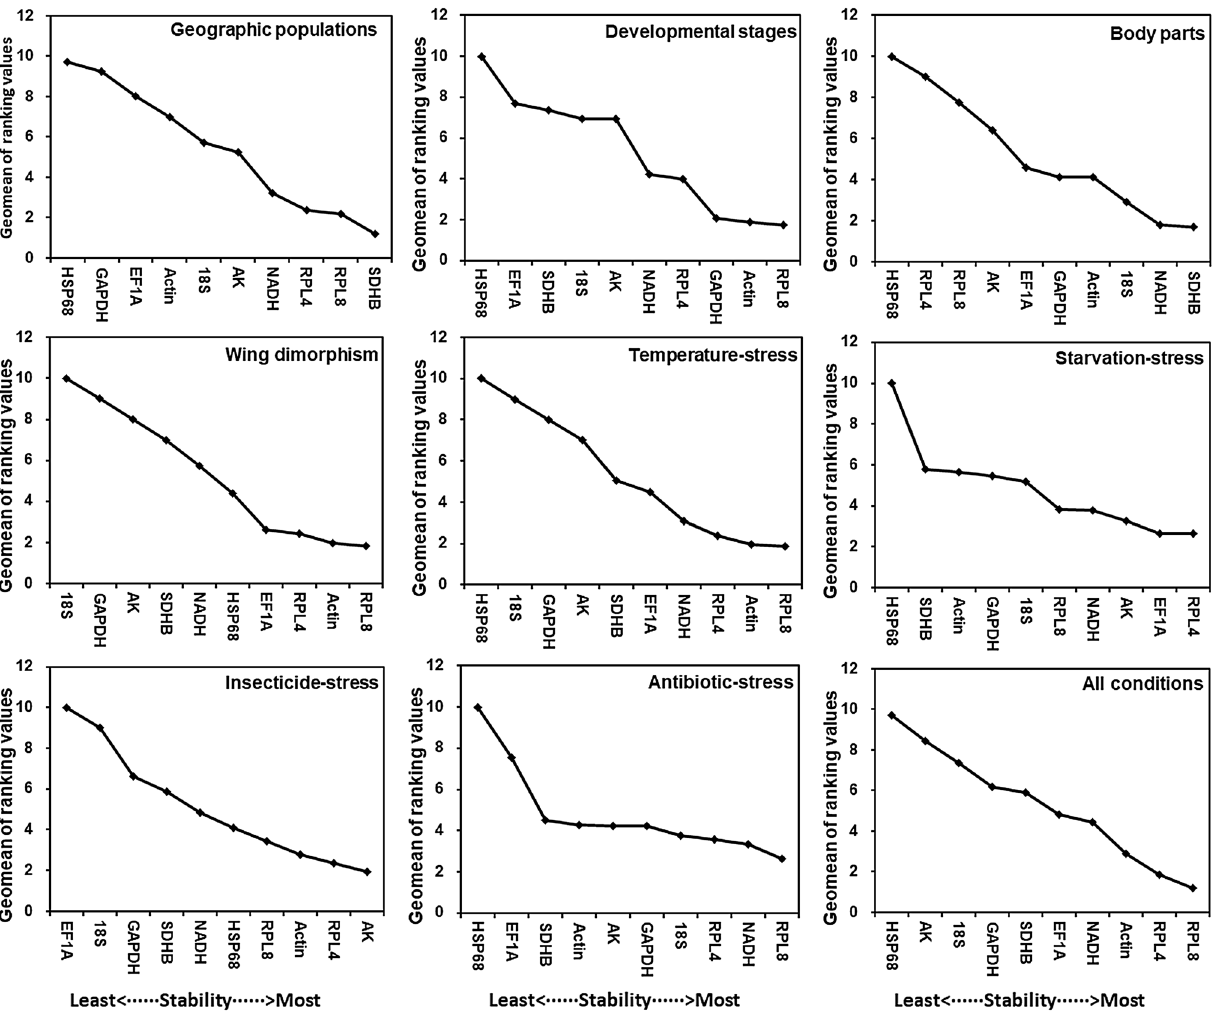
Figure 2. Stability of candidate reference gene expression levels in response to various treatments and conditions. In a RefFinder analysis, decreasing Geomean values correspond to increasing gene expression stability. The Geomean values for the following M. dirhodum samples are presented: adult samples from different geographic populations (Geographic population), samples for all developmental stages (Developmental stages), samples for different body parts of wingless adults (Body part), samples for winged and wingless adults (Wing dimorphism), adult samples exposed to different temperatures (Temperature-stress), fed and unfed adult samples (Starvation-stress), adult samples treated with different insecticides (Insecticide-stress), adult samples treated with antibiotic (Antibiotic-stress), and all samples for all treatments (All conditions). The candidate reference genes are as follows: Actin , Actin ; GAPDH , glyceraldehyde-3-phosphate dehydrogenase ; NADH , NADH dehydrogenase ; AK , arginine kinase ; SDHB , succinate dehydrogenase B ; RPL8 , ribosomal protein L18 ; RPL4 , ribosomal protein L4 ; HSP68 , heat shock protein 68 ; 18S , 18S ribosomal RNA ; and EF1A , elongation factor 1α were below the 0.15 cut-off value, except for V9/10 (Fig. 3). The RefFinder analysis indicated SDHB and NADH are required for normalizing target gene expression levels in various M. dirhodum body parts. Wing dimorphism. The delta Ct and BestKeeper analyses identified Actin and RPL4 as the most stable genes, whereas both NormFinder and GeNorm identified RPL8 and EF1A as the most stable genes. All four analyses indicated that 18S , GAPDH , AK , and SDHB were the least stable genes (Table 1). The RefFinder data for the wing dimorphism revealed a rank order (most to least stable expression) of RPL8 , Actin , RPL4 , EF1A , HSP68 , NADH , SDHB , AK , GAPDH , and 18S (Fig. 2). On the basis of the GeNorm analysis, all pairwise variation values were below the 0.15 cut-off value (Fig. 3). According to RefFinder, RPL8 and Actin are required for normalizing target gene expression levels in wing-dimorphic insects. Temperature-induced stress. The delta Ct method identified Actin and RPL8 as the most stable genes. Both BestKeeper and NormFinder identified RPL8 and RPL4 as the most stable genes, whereas GeNorm identified Actin and NADH as the most stable genes. All four analyses indicated HSP68 , 18S , GAPDH , and AK were the